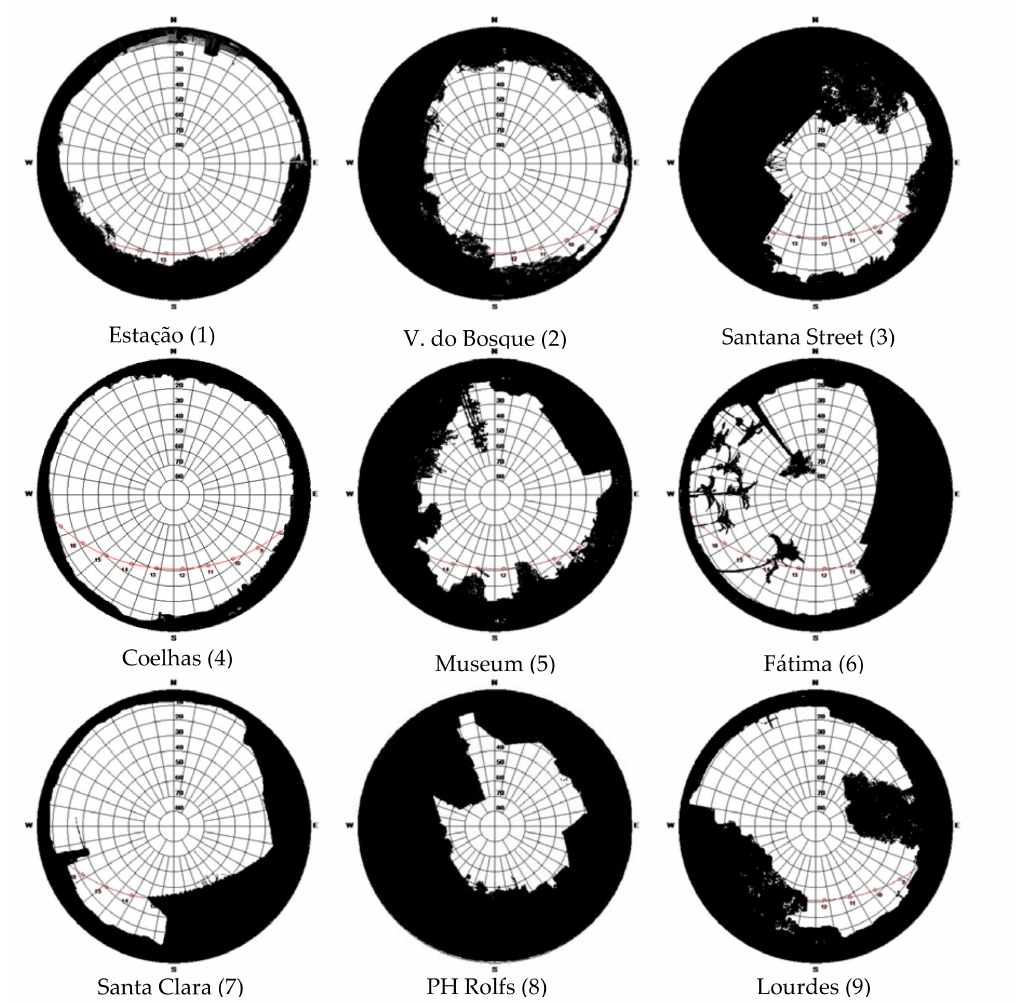
Figure 4. Hemispherical photographs with solar trajectory of collection points in the municipality of Viçosa (MG). Source: BIOCLIMA—UFV. Organization: Ludmilla Alves